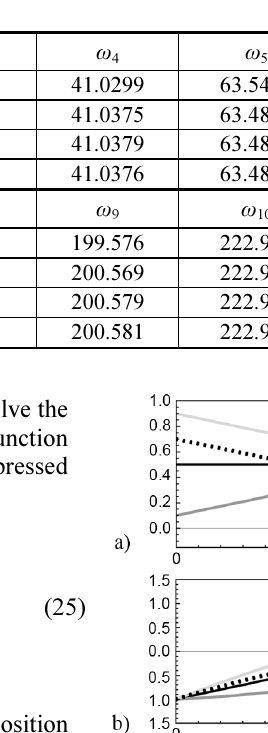
002 EIa ρω Ω= of H-C Catenary arch